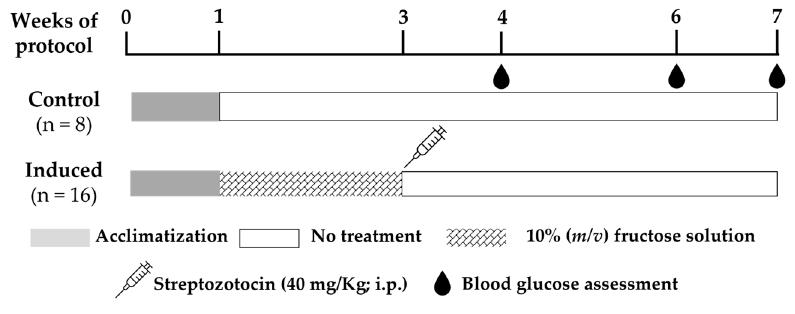
Figure 1. Experimental design.